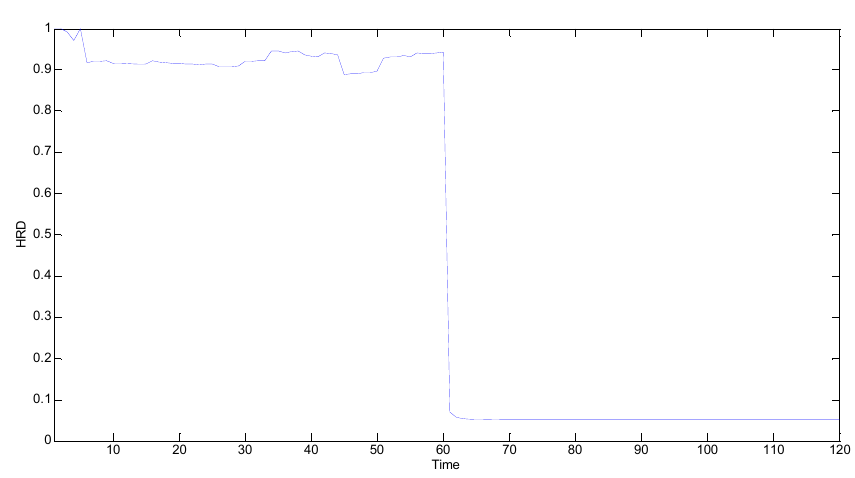
Figure 17. HRD s of faulty